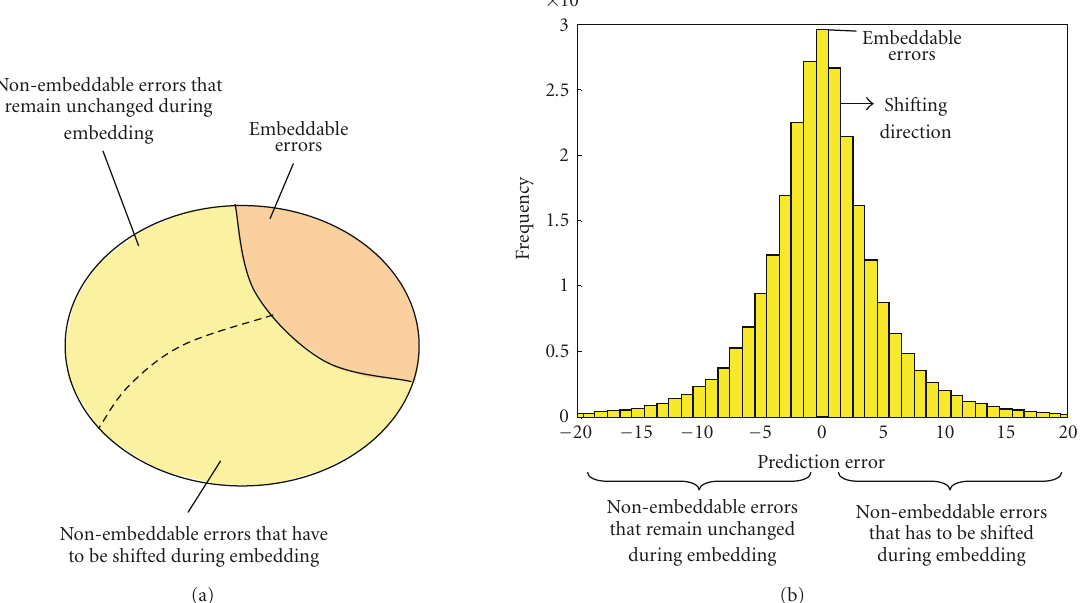
Non-embeddable errors that remain unchanged during